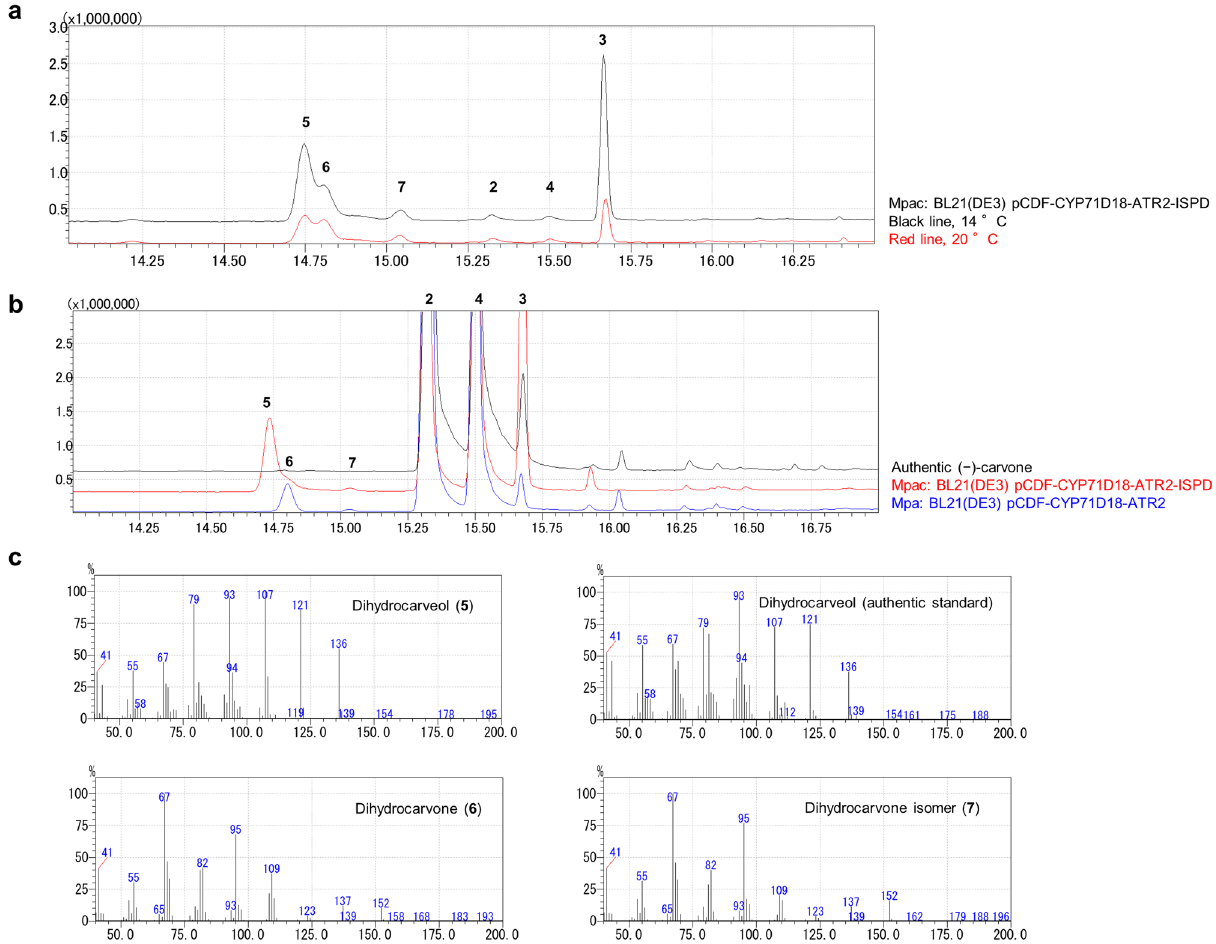
Figure 3. Carvone production from limonene using a recombinant Escherichia coli strain co-expressing P450, CPR, and CDH, and identification of by-product compounds. Cytochrome P450 limonene-6-hydroxylase gene from spearmint ( CYP71D18 ), cytochrome P450 reductase (CPR) gene from Arabidopsis thaliana ( ATR2 ) and carveol dehydrogenase (CDH) gene from peppermint ( ISPD ) were used as P450, CPR, and CDH, respectively. Their enzymatic activities were confirmed by gas chromatography (GC) analysis. ( a ) Reaction with (−)-limonene and cells co-expressing P450, CPR, and CDH (Mpac strain; BL21(DE3) pCDF-CYP71D18-ATR2- ISPD) under different temperature conditions (black line, 14 °C; and red line, 20 °C). Mpac strain converted (−)-limonene to (−)-carvone, and also generated by-products. ( b ) Reaction with (−)-carveol and cells expressing P450, CPR, and CDH (Mpac strain, red line), and cells expressing P450 and CPR (Mpa strain, blue line). The Mpac strain generated an undetermined by-product, compound (5). The Mpa strain generated an undetermined by-product, compound (6, 7). The black line indicates authentic (−)-carveol standard. Commercially available (−)-carveol contains (−)- trans -carveol (2), (−)- cis -carveol (4), and trace of (−)-carvone (3). ( c ) Mass spectrometry (MS) fragment pattern of reaction products with (−)-limonene and cells expressing P450, CPR and CDH (Mpac strain), and the authentic standard (dihydrocarveol). Fragment patterns determined by GC– MS analysis indicated that the undetermined by-products were dihydrocarveol and dihydrocarvone. Numbers indicate the following compounds: (−)- trans -carveol (2), (−)-carvone (3), (−)- cis -carveol (4), dihydrocarveol (5), dihydrocarvone (6), dihydrocarvone isomer